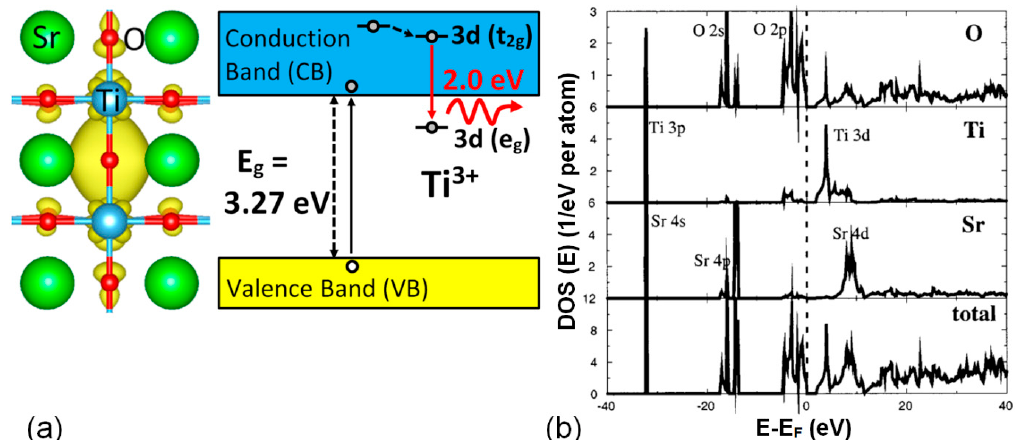
Figure 8. ( a ) Schematic for possible mechanism of the electronic processes involved in the red luminescence band for STO associated with the oxygen vacancy. The conduction band (CB) is mainly composed of 3d ( t 2g ) and 3d ( e g ) orbitals of Ti, and the upper valence band (VB) is associated with O 2p states, hybridized with Ti and Sr states. The well-defined 2.0 eV emission band observed at LT is attributed to d–d transitions (inside TiO 6 octahedron) from electrons that are self-trapped as relaxed Ti 3 + centers adjacent to oxygen vacancies [9]. A density functional theory (DFT) calculation of the electronic density of states (DOS), similar to that calculated by Ricci et al. [12], showing the doubly occupied impurity state in the gap associated with the oxygen vacancy in the axis containing Ti 3 + − V O − Ti 3 + , is included next to the schematics. ( b ) Ab-initio calculation in the local density approximation (LDA) of total and site projected DOS for oxygen, titanium, and strontium, respectively. ( a ) has been adapted from Crespillo et al. [9], Copyright (2018), with permission from Elsevier, and ( b ) has been reproduced from [35], with the permission of AIP Publishing.